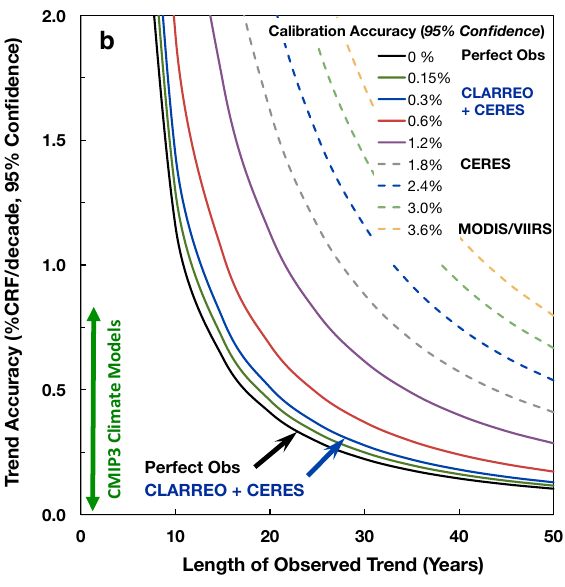
Figure 1. Accuracy of current earth observing missions and the potential improvement by CLARREO (Wielicki 2013) Figure 1 shows the accuracy trend of cloud radiative forcing per decade as a function of the length of the observed trend. Current missions are shown and include CERES and MODIS/VIIRS, where it is clear that the length of time necessary to reach 1% accuracy in cloud radiative forcing is 30 years with current instruments alone. The time to detect a trend is reduced by nearly 20 years with the addition of an instrument of CLARREO’s accuracy levels (Wielicki